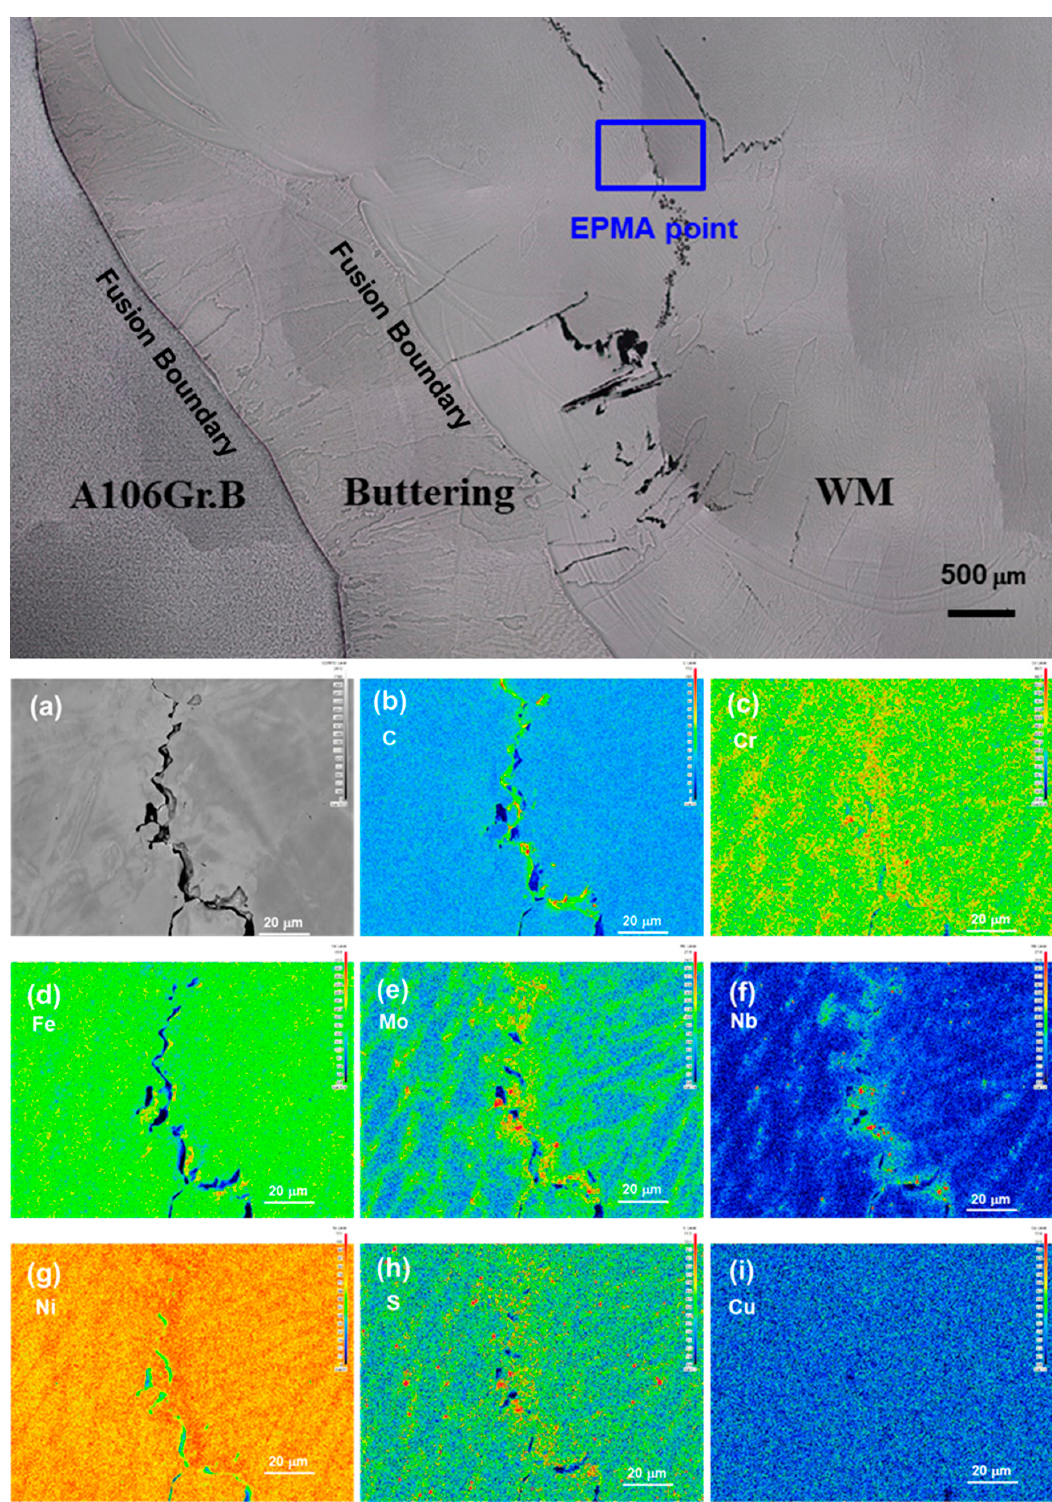
Figure 6. A combined figure with several OM figures showing cracks in the WM (Top); ( a ) SEM micrograph of crack in the WM; FE-EPMA elemental mapping near the crack: ( b ) C; ( c ) Cr; ( d ) Fe; ( e ) Mo; ( f ) Nb; ( g ) Ni; ( h ) S; ( i ) Cu. Figure 7 shows SEM micrographs and EDS spectra of the precipitates found near the crack in the WM. The weld pool was solidified below solidus temperature due to constitutional super cooling.